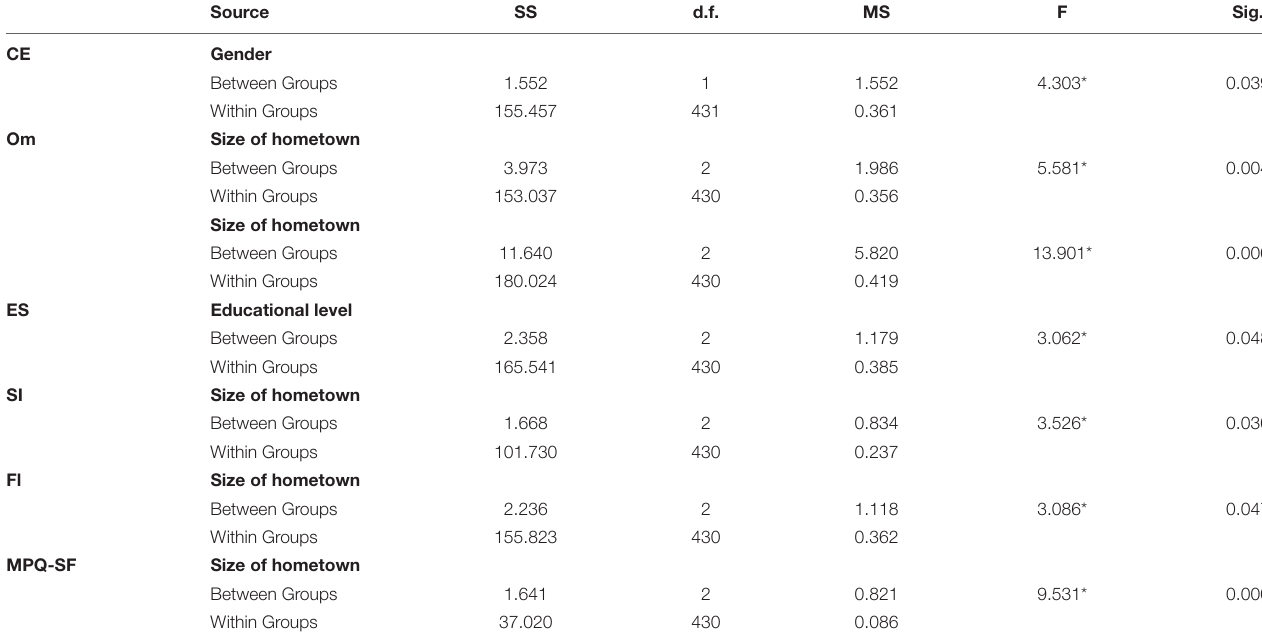
TABLE 3 | Results of analysis of variance categorical demographics variables and